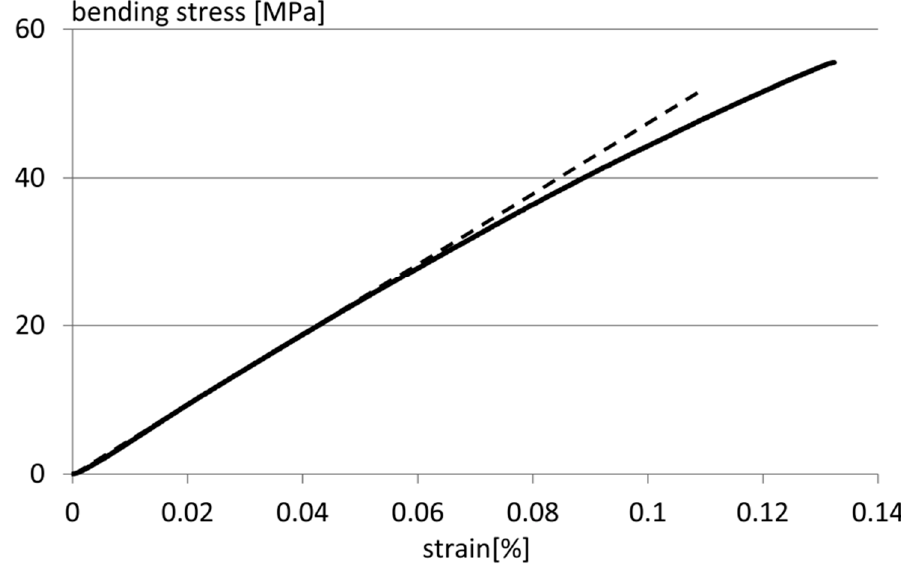
Figure 6. Stress-strain graph of sample 4SH35D (as-received).